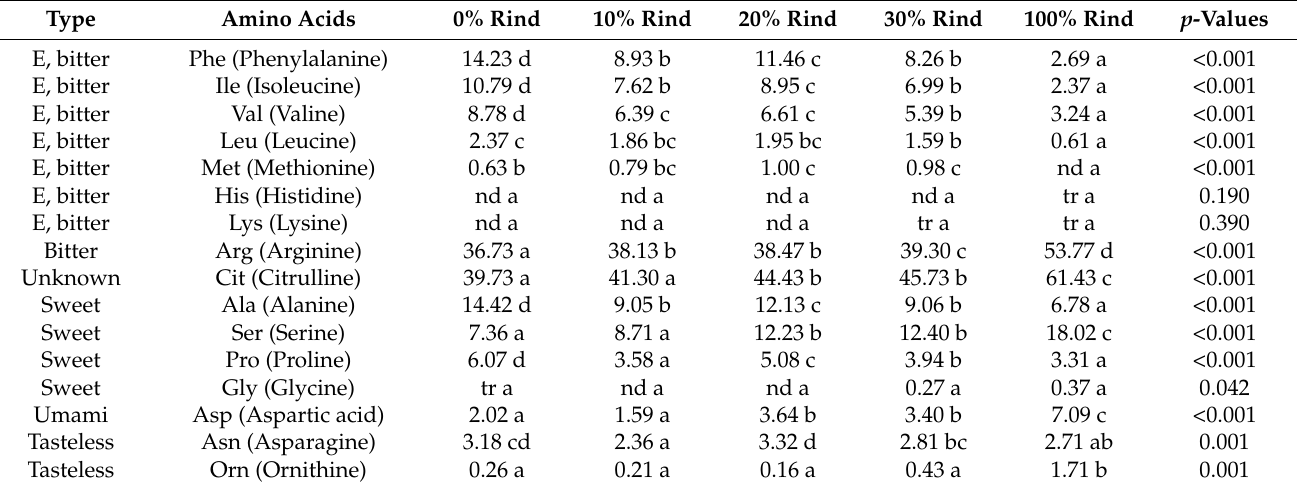
Figure 1. Total free amino acids (sum of 16 amino acids, mg/100 g fresh weight) in watermelon rind, flesh, and rind-flesh blends. Different letters (a–c) among five samples indicate significant differences according to one-way ANOVA and Tukey’s HSD test with p ≤ 0.05. Table 1. Mean values (mg/100 g fresh weight) of free amino acids identified and quantified in watermelon rind, flesh, and rind-flesh blends.